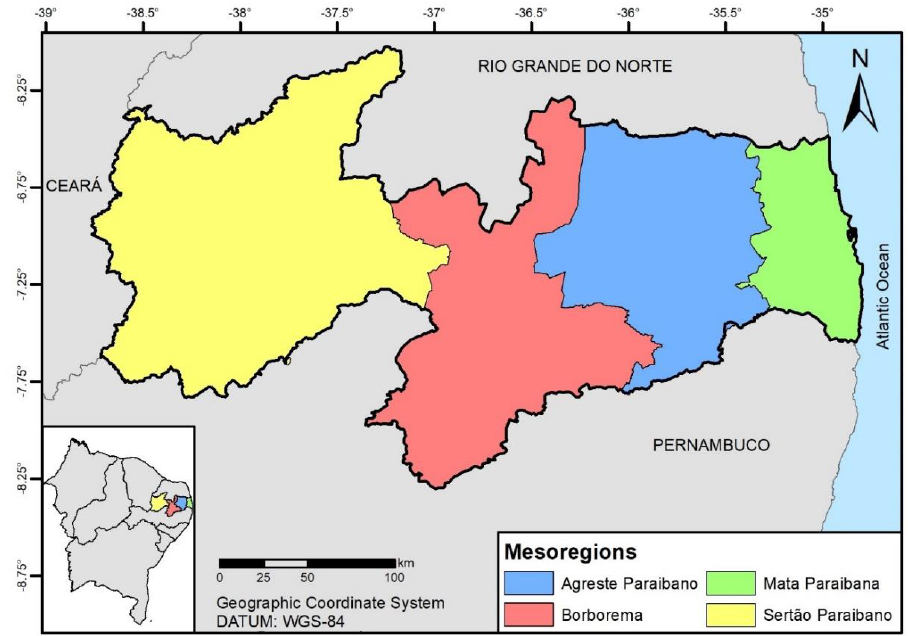
Figure 1. Location of Paraíba State with mesoregions in northeastern Brazil.